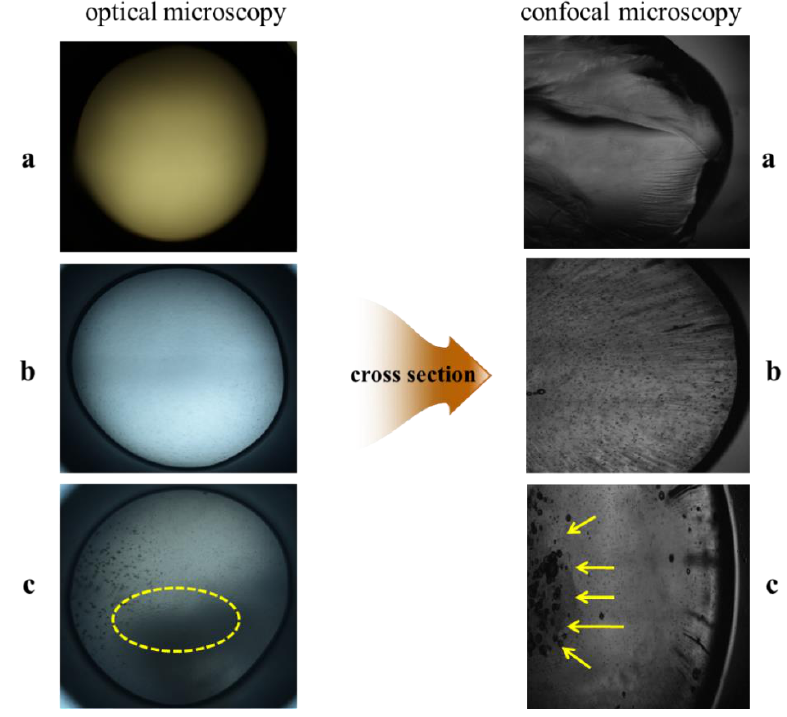
Figure 3. Capsule morphology observed by optical microscopy (left, ×50), and confocal microscopy (right, ×100): ( a ) control ( b ) cells-without OCs*, ( c ) cells with OCs. * OCs: oxygen capsules.